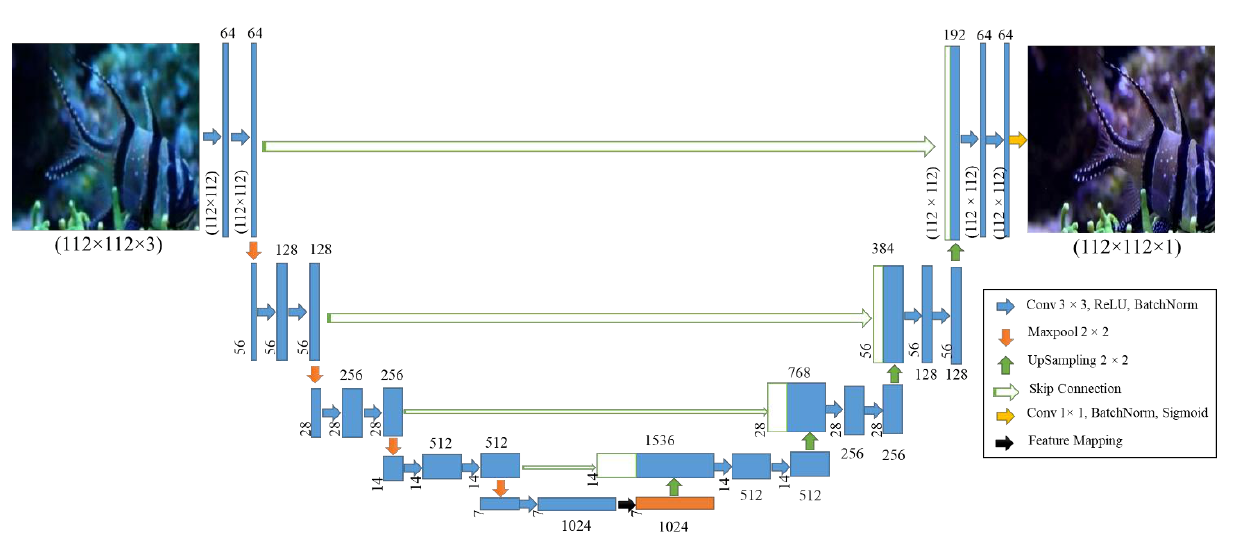
Fig. 4. Modified architecture of the autoencoder for testing the images .